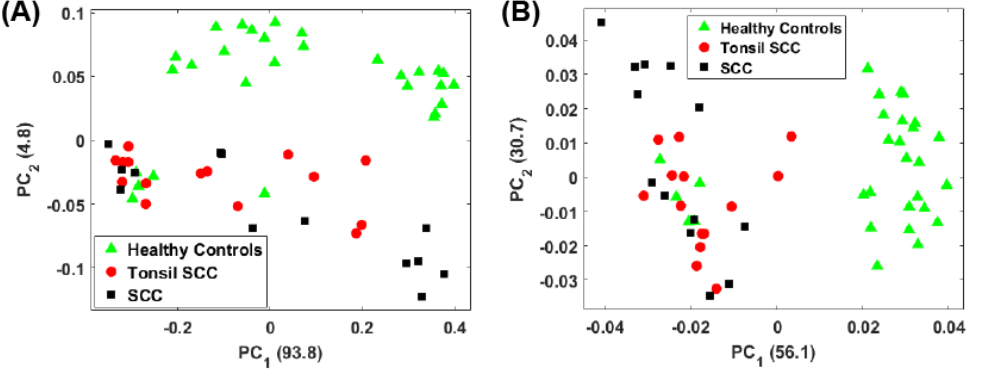
Figure 4. Plot of the first two principal component scores for ( A ) for the full spectrum (100 cm − 1 –4300 cm − 1 ) and ( B ) the conventional fingerprint (400 cm − 1 –1800 cm − 1 ). Both plots show good separation between the healthy controls and the malignant tissue samples (both tonsil squamous cell carcinoma and squamous cell carcinoma). The numbers in parentheses represent the information content associated with each principal component.